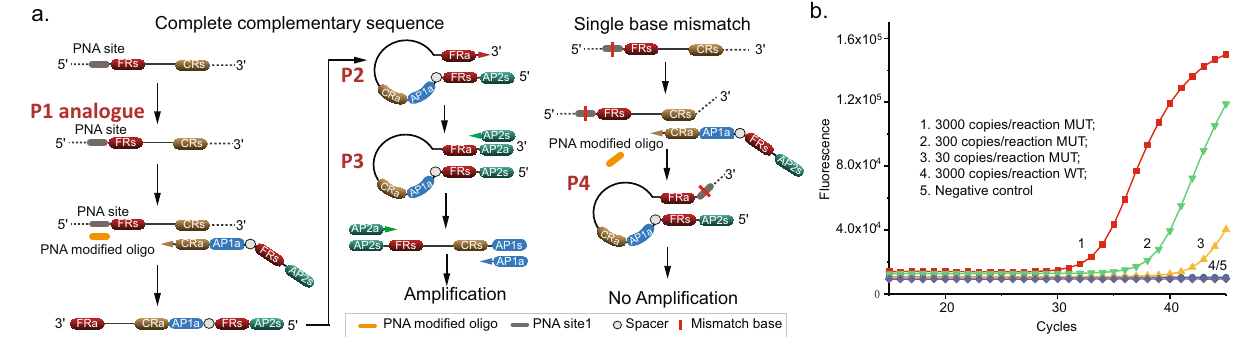
Fig. 4 | STEM-PCR for site-speci fi c detection with PNA-modi fi ed oligo. a The mechanism of PNA-modi fi ed oligo-mediated STEM-PCR for single base mismatch detection; b The ampli fi cation results of L858R mutation using PNA-based STEM- PCR. (1) 3000 copies/reaction (red squares); (2) 300 copies/reaction (green down